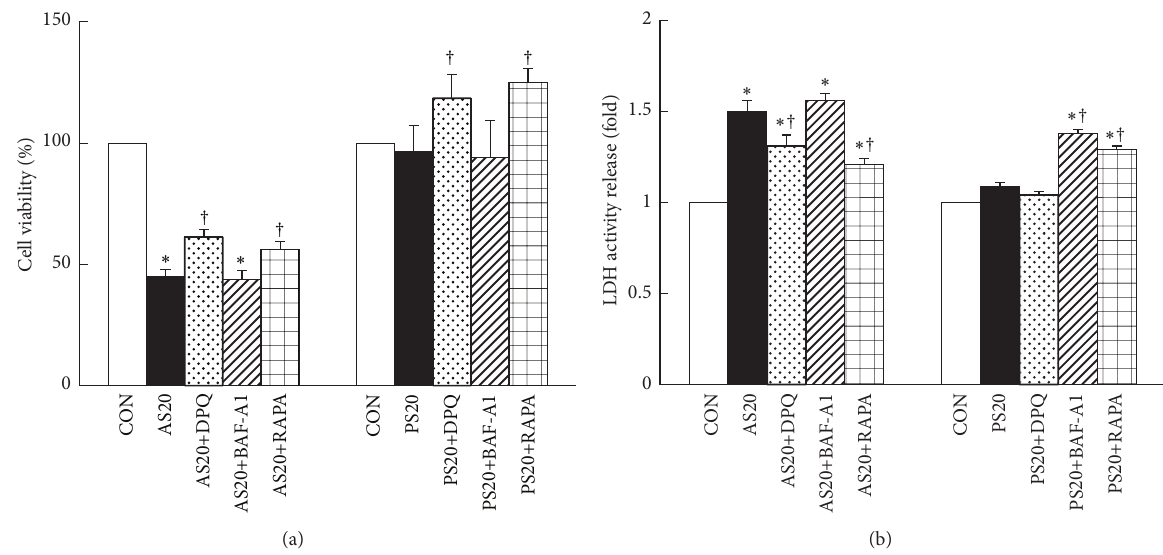
Figure 4: Autophagy plays a prosurvival role in AS- and PS-mediated cell outcome. (a) NIT-1 cells in AS exhibited substantially decreased cell viability. When pretreated with DPQ or RAPA, the cells increased in number; the autophagy inhibitor BAF-A1 mildly reduced cell viability. DPQ or RAPA exhibited increased cell viability in 20 𝜇 M PS-treated cells, and BAF-A1 exhibited a mild decrease in cell viability. (b) LDH activity release in the NIT-1 cells after treatment with AS with or without DPQ, BAF-A1, and RAPA; DPQ and RAPA pretreatment significantly reduced LDH activity release; BAF-A1 significantly increased LDH activity release. Similarly, BAF-A1 significantly increased LDH activity release in NIT-1 cells treated with PS for 48 h, and RAPA pretreatment can attenuate BAF-A1-associated increase in LDH activity release. DPQ did not change the percentage of LDH activity release. The value for the CON group was set at 1. † 𝑃 < 0.05 , compared to the only AS- or PS-treated group; mean ± SD from three